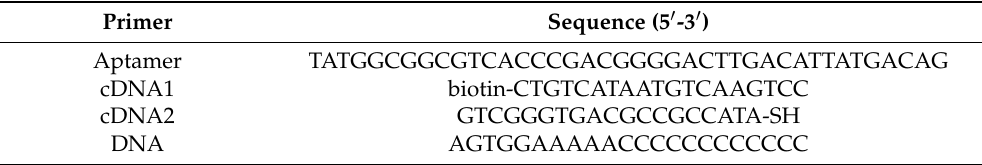
Table 1. All oligonucleotide sequences used in this